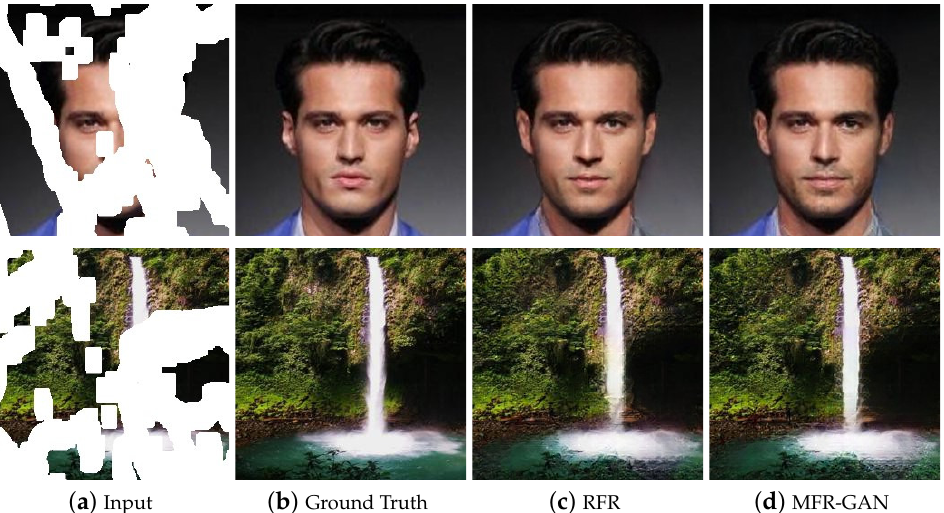
Figure 1. Comparing the proposed method with the state-of-the-art progressive image restoration method [15]. The missing regions are shown in